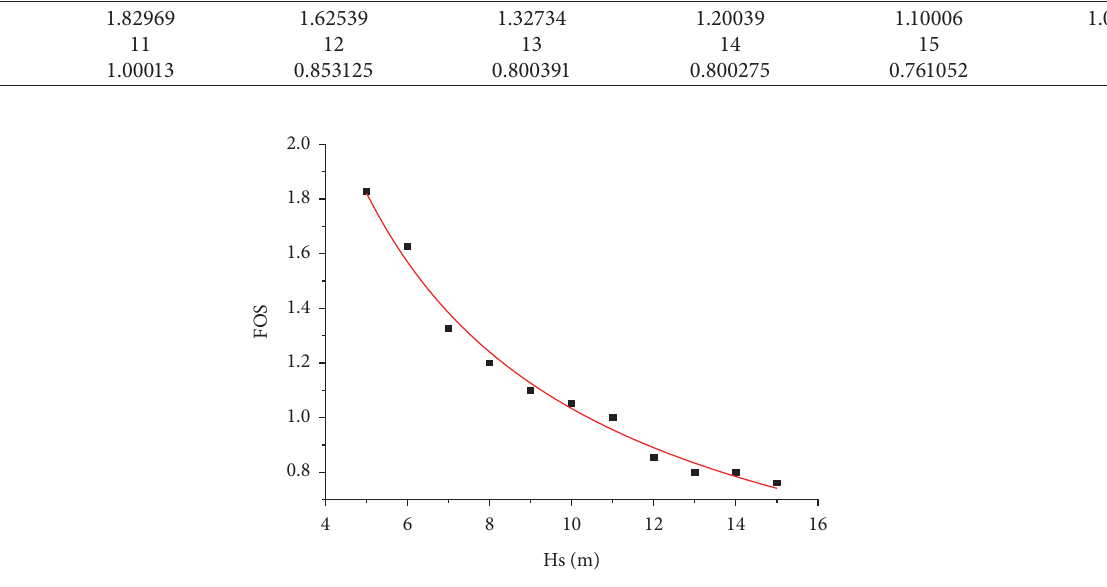
Figure 7: Variation curve of the FOS with Hs